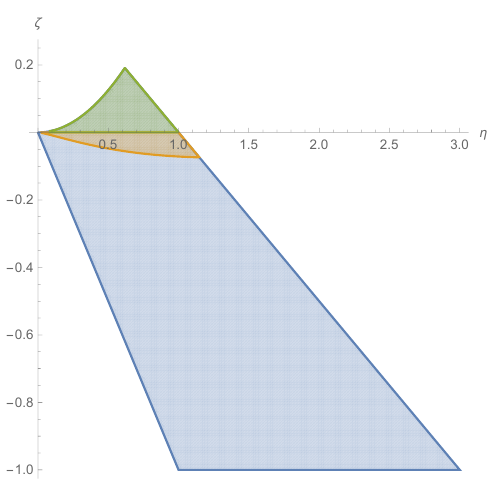
Figure 2 . In the green region, the mode (cid:23) (cid:0) ( k ) is complex for a range of wavevectors k (cid:0) < k < k + , while it is real in the brown and blue regions for all values of k . In the brown region, 2 (cid:23) (cid:0) (cid:0) 1 < 0 for a range of wavevectors k ? < k < k ? while in the blue region 2 (cid:23) (cid:0) (cid:0) 1 > 0, for any real k . The (cid:0) + brown region of this plot is entirely contained within the brown region of (cid:12)gure